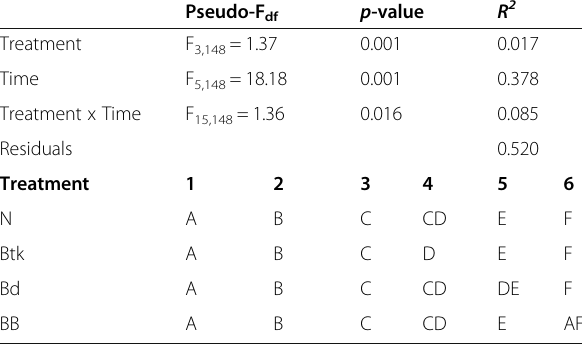
Table 2 Results from PERMANOVA analysis of bacterial communities across treatment, time, and their interaction as well as residuals. Connecting letters reports are presented using post-hoc pairwise PERMANOVAs where sampling events (1 – 6) that have different letters differ in community structure ( P <